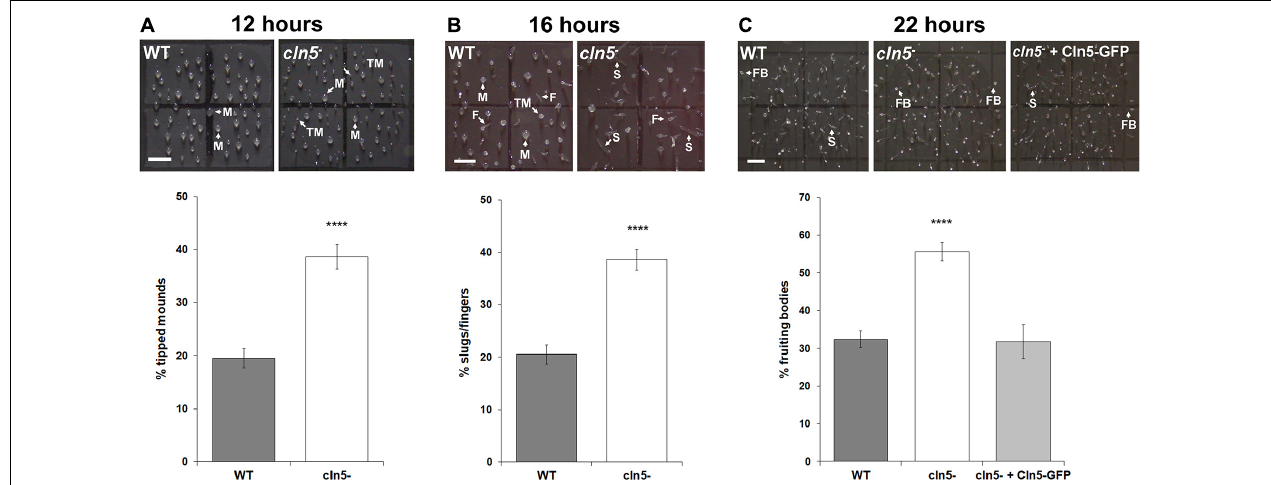
FIGURE 9 | Effect of cln5 -deficiency on the mid-to-late stages of development. (A) Effect of cln5 -deficiency on tipped mound formation after 12 h of development. Data presented as mean percentage of tipped mounds ± SEM ( n > 84). (B) Effect of cln5 -deficiency on finger and slug formation after 16 h of development. Data presented as mean percentage of fingers/slugs ± SEM ( n > 88). (C) Effect of cln5 -deficiency on fruiting body formation after 22 h of development. Data presented as mean percentage of fruiting bodies ± SEM ( n > 32). Arrows (white) indicate mounds (M), tipped mounds (TM), slugs (S), fingers (F), and fruiting bodies (FB). Scale bar = 1 mm. Statistical significance for panels (A,B) was determined using the Student’s t -test. Statistical significance for panel (C) was determined using one-way ANOVA followed by Tukey’s multiple comparisons test. **** p -value < 0.0001 vs. WT.